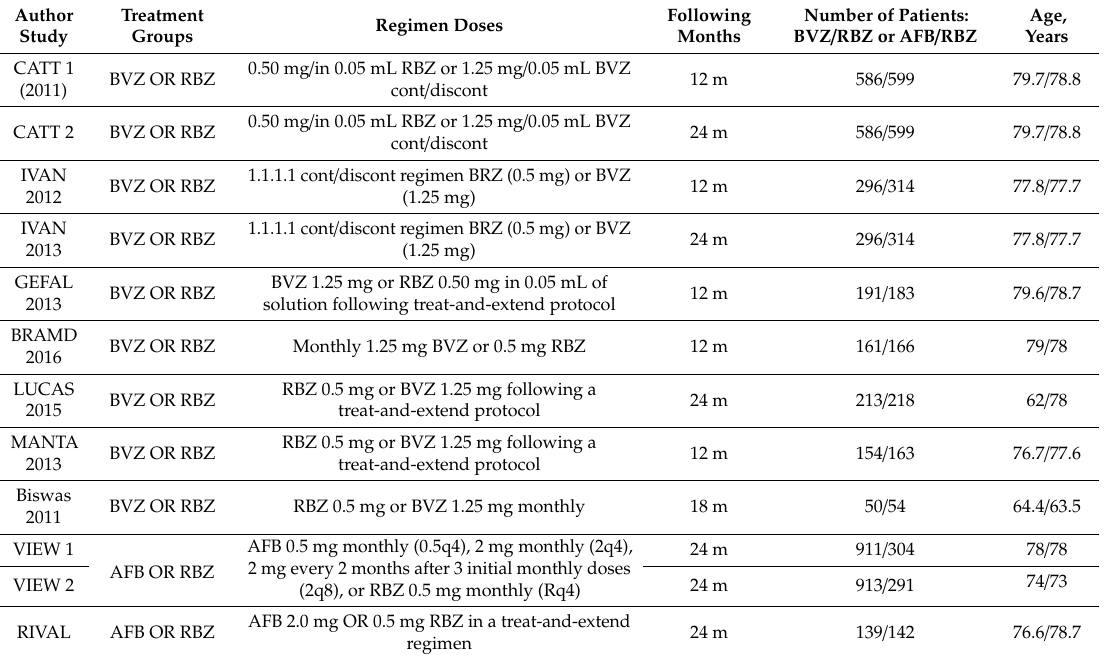
Table 3. Basic characteristics of the RCT included in the analysis.